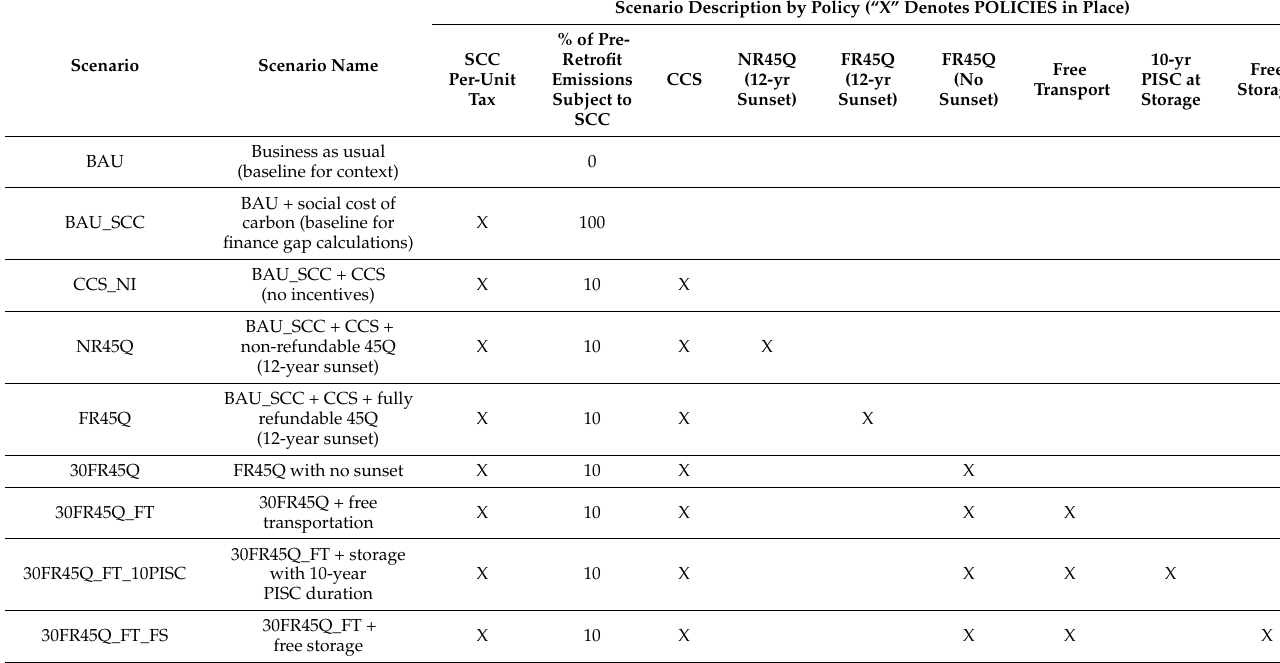
Table A5. Scenarios described by policy in